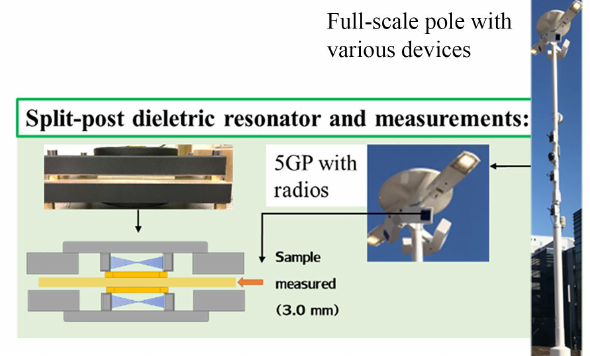
Figure 6. Attenuation measurements of radome/pole structure’s material samples representing signal windows; radome and measurement setup by using the SPDR